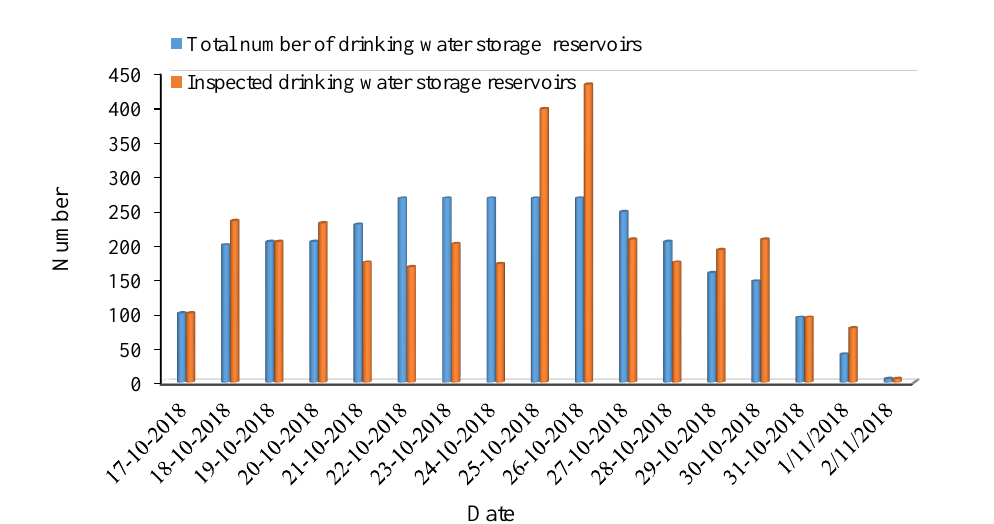
Fig. 6. Drinking water reservoirs and number of inspected reservoirs per